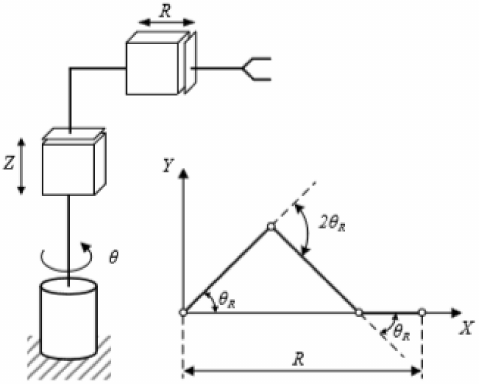
Figure 3. Principle diagram of the common platform.